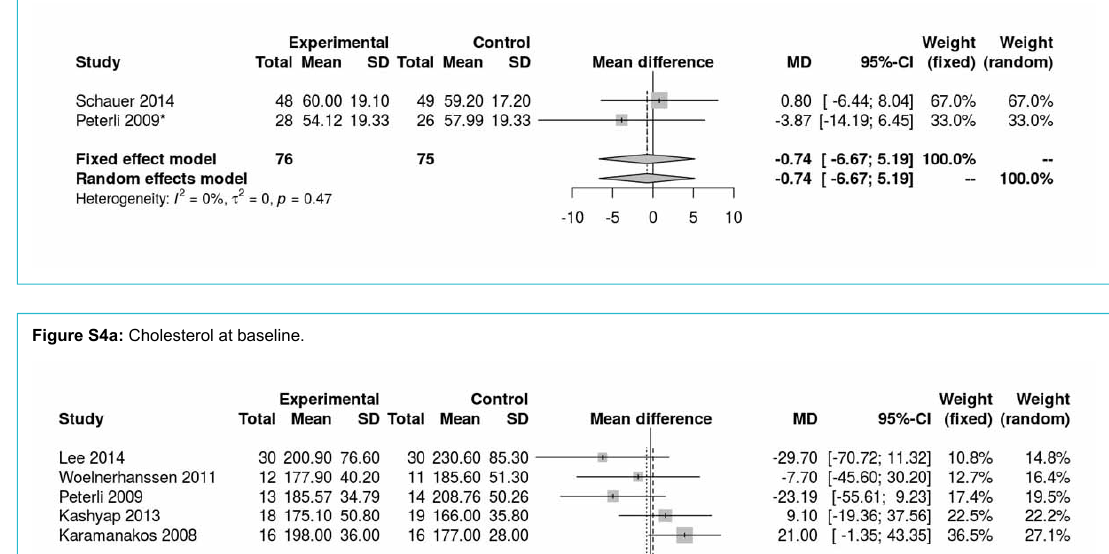
Figure S3c: High-density lipoprotein at 36 months.